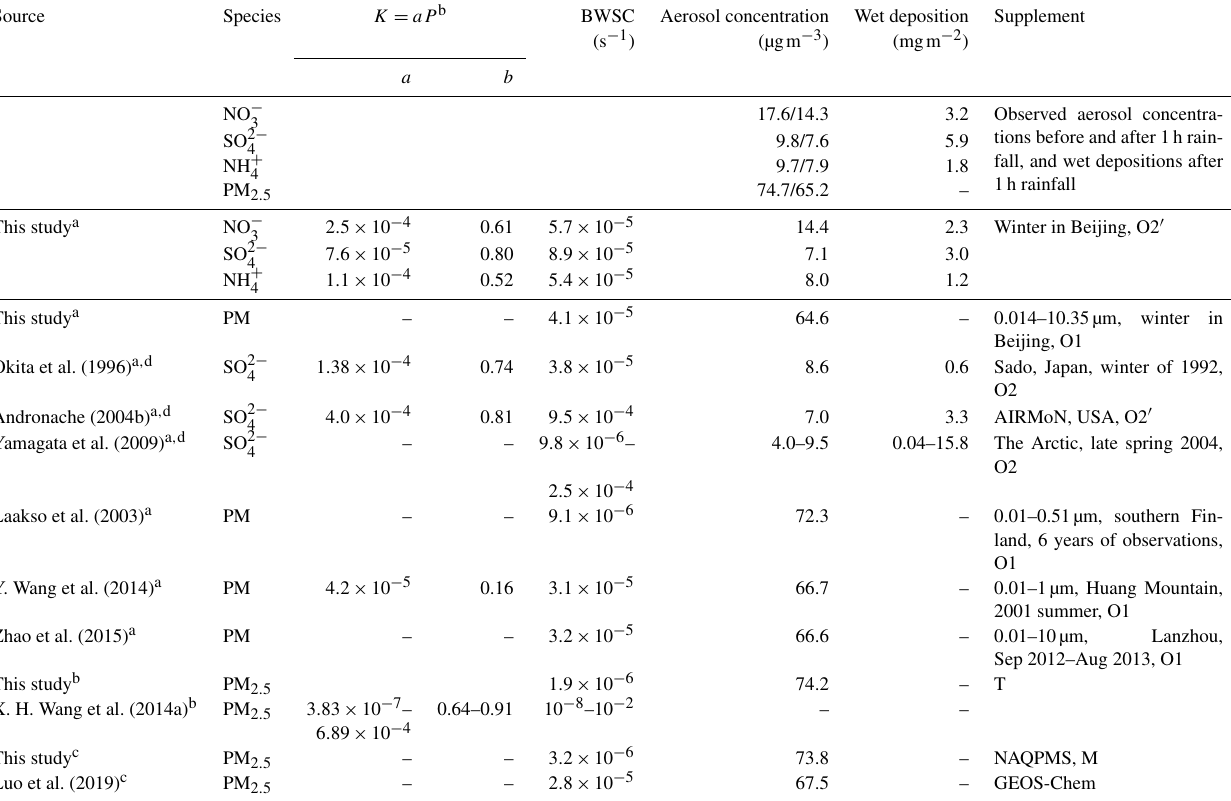
Table 2. The observed aerosol concentrations before and after 1h rainfall; wet depositions after 1h rainfall; and parameters of the exponential power fittings, WSCs, rebuilt aerosol concentrations, and wet depositions after 1h compared with multi-method determination.